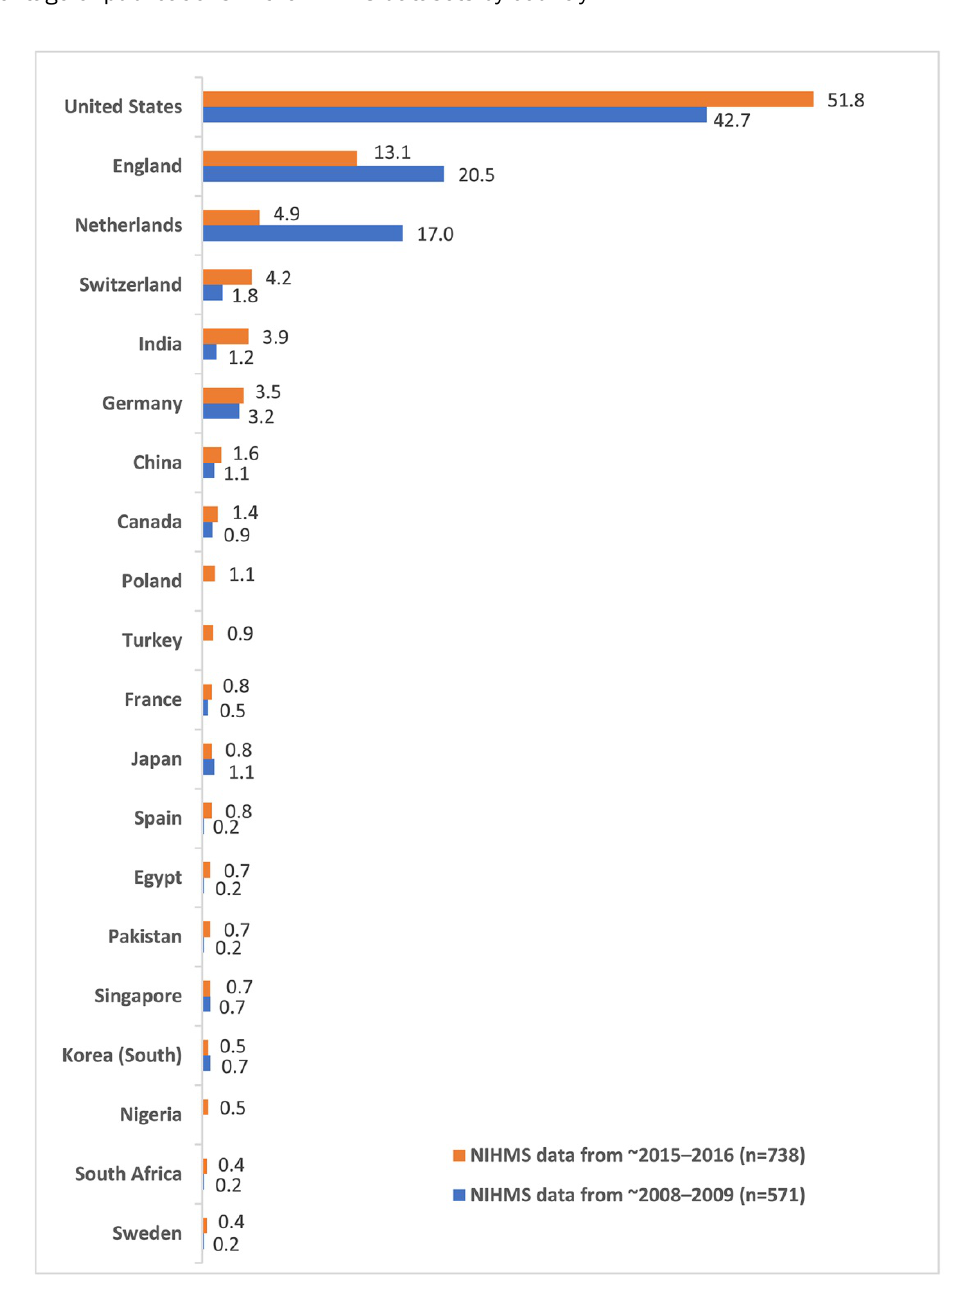
Figure 2 Percentage of publications in the NIHMS datasets by country